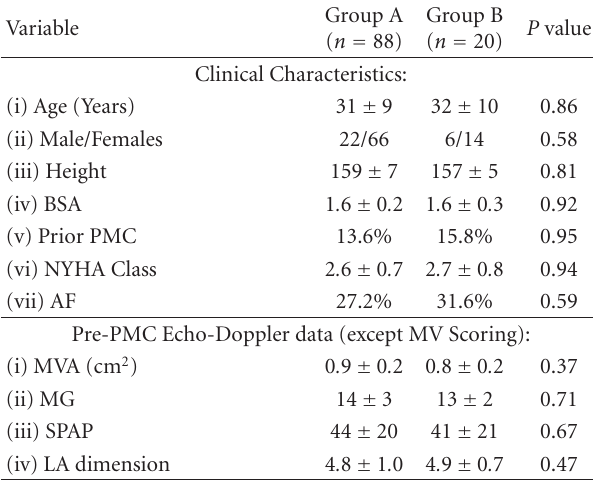
Table 3: MV Scoring